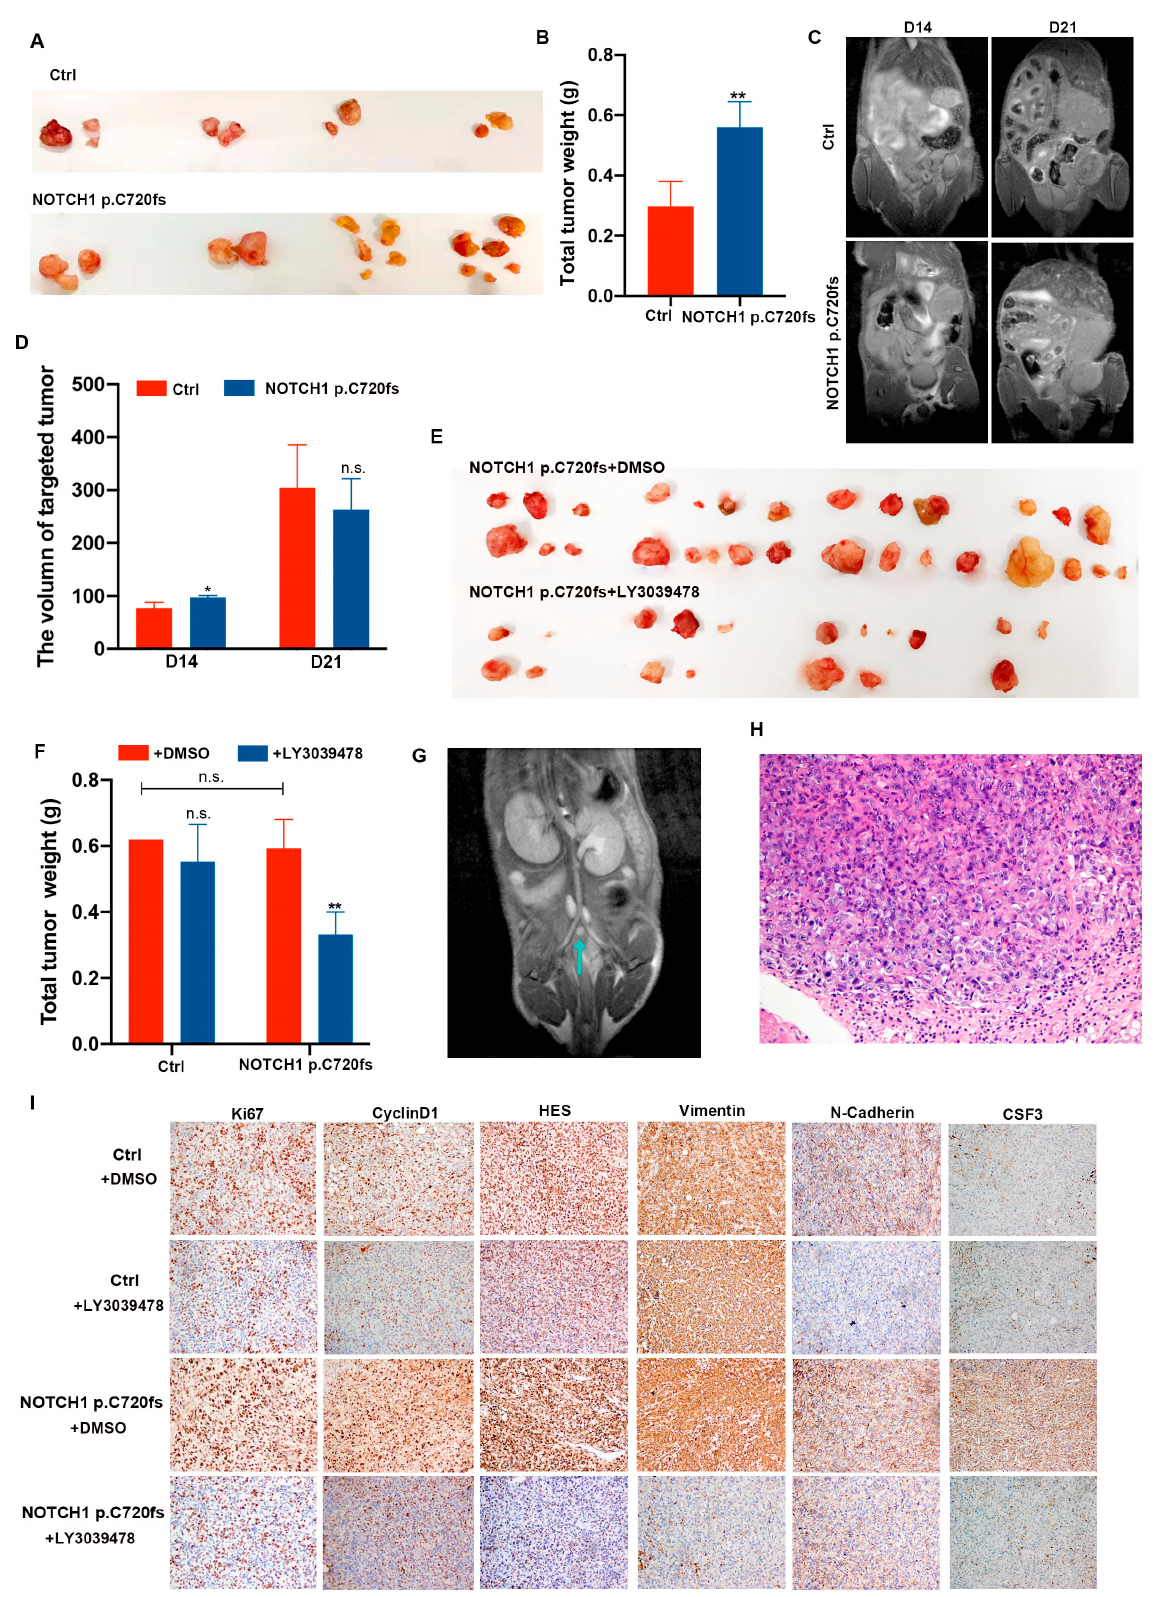
Figure 4. NOTCH1 -p.C720fs mutation promotes implantation and the lymph node metastasis of ovarian cancer in vivo, which can be inhibited by LY3039478. ( A , B ) NOTCH1 -p.C720fs